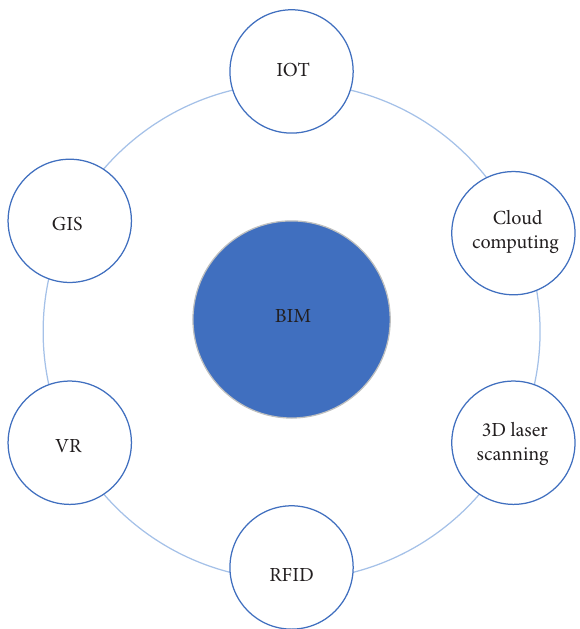
Figure 6: Integration diagram of BIM and other advanced